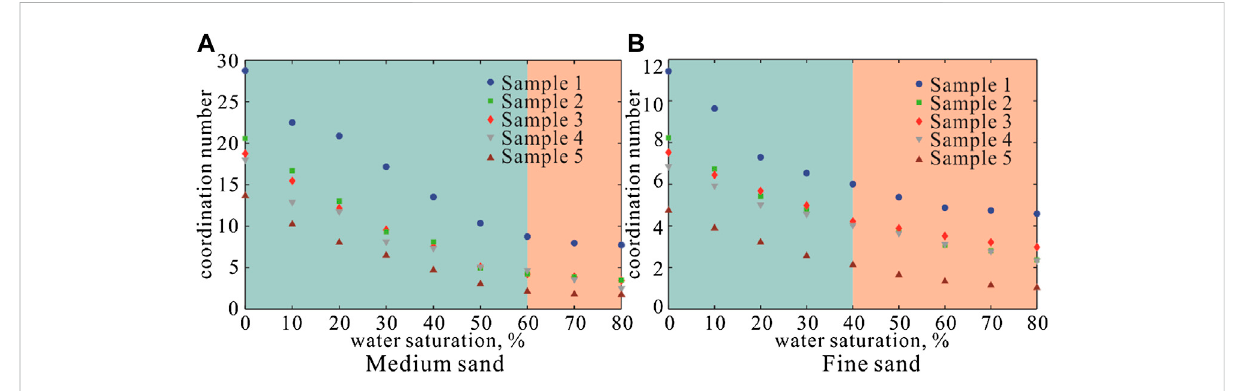
FIGURE 15 The variation of pore connectivity with increasing water saturation in sandstones of different grain sizes (A) shows the variation of pore connectivity with increasing water saturation in medium sand; (B) shows the variation of pore connectivity with increasing water saturation in fi ne